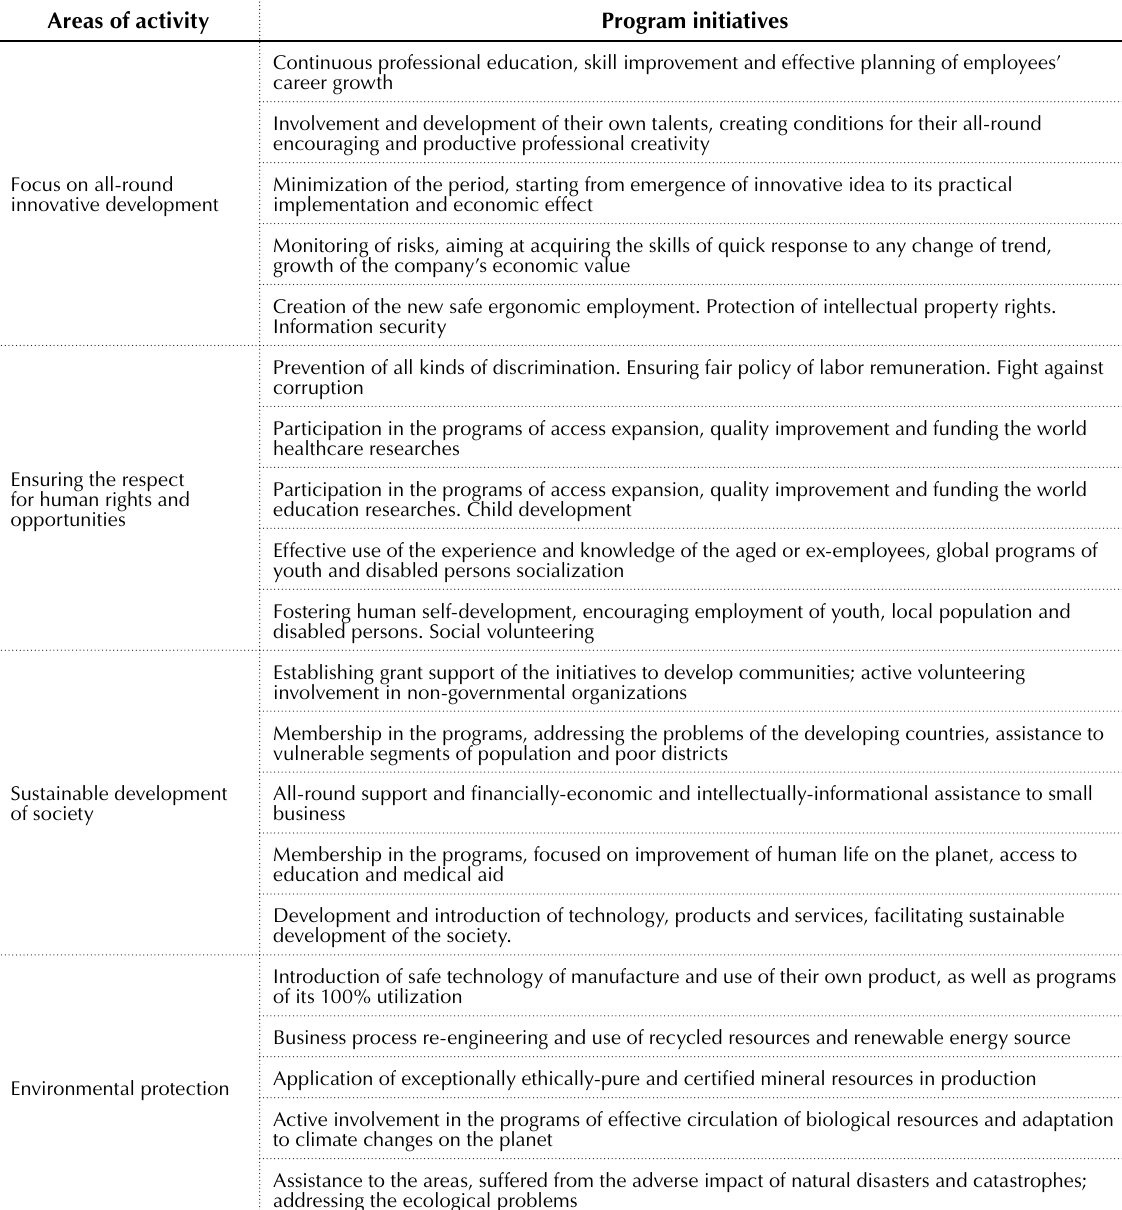
Table 3. Priority areas of the international companies’ activity Areas of